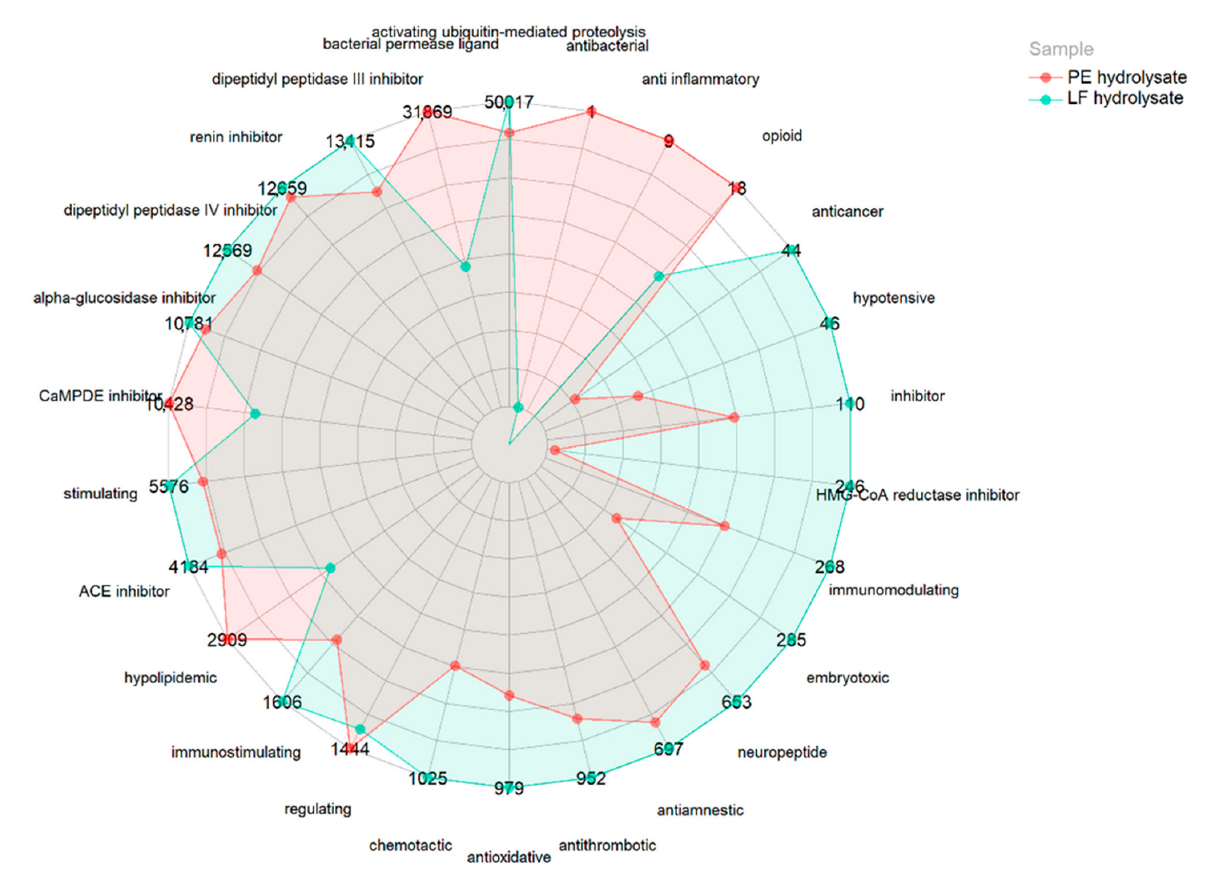
Figure 2. Normalized quantification of potential bioactive sequences ( × 10 − 3 ) of raw larva meal (LF) and its protein extract (PE) hydrolysates. Liquid chromatography–mass spectrometry peptide spectral matches (PSM) have been conducted considering the existence of reported bioactive sequences within their primary structure. The values were normalized considering the PSM of the total peptides in the hydrolysates. Thus, the quantification of a sequence between the hydrolysates was comparable.